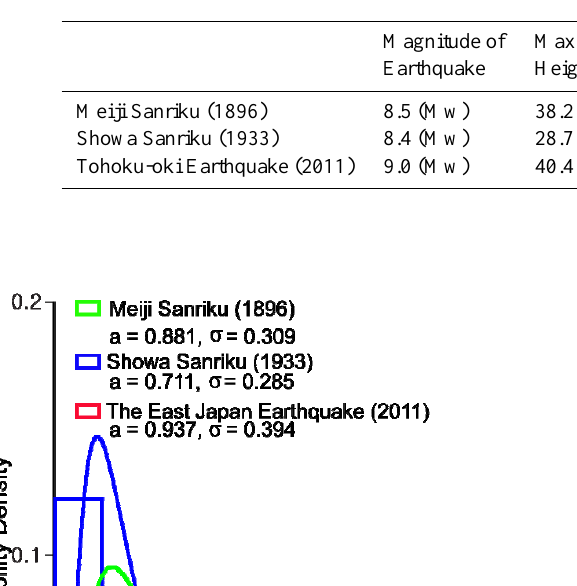
Table 1. Characteristics of Sanriku tsunamis.